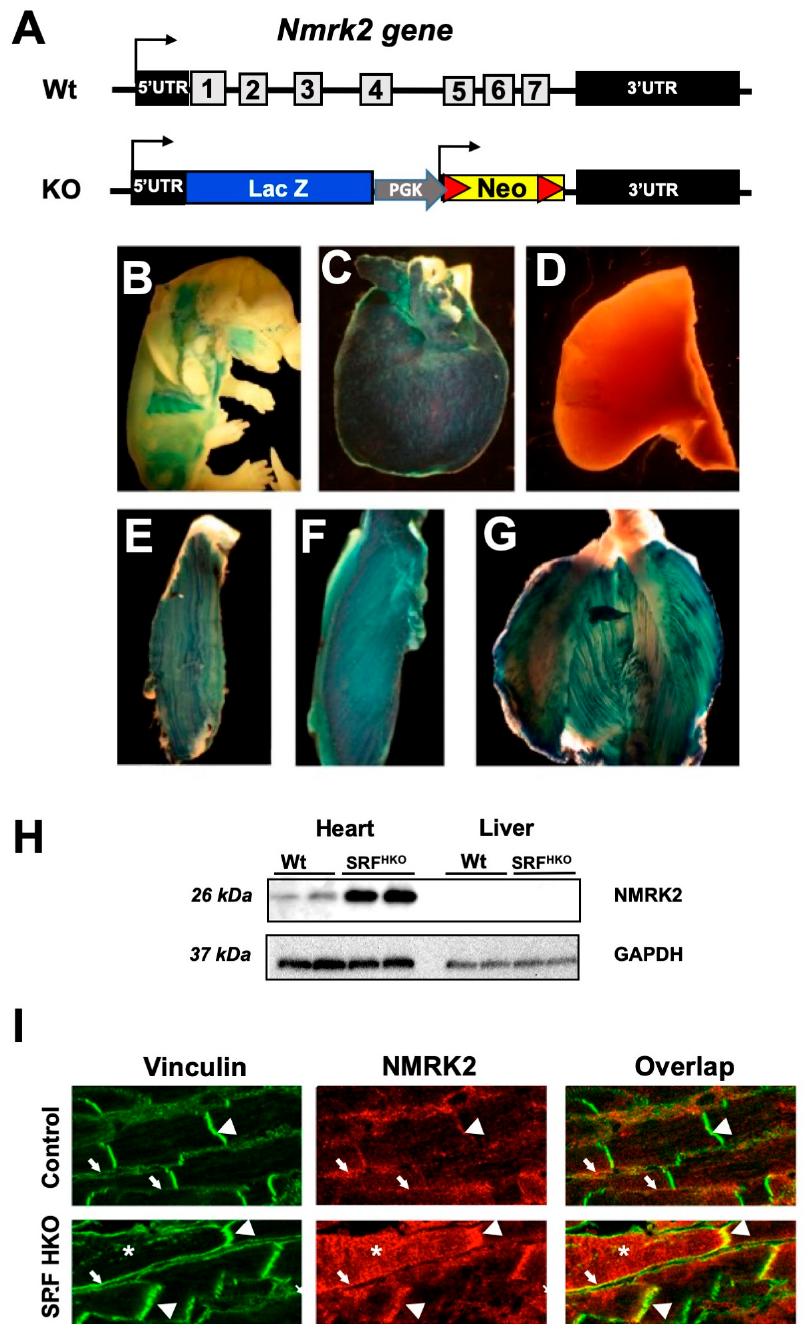
Figure 2. Nmrk2 gene knock-out design and expression pattern. ( A ) Definitive null allele was obtained by replacement of all exons and introns of the Nmrk2 gene by an expression cassette including the lacZ reporter gene and a floxed neomycin resistance gene. ( B – G ) The lacZ gene, which is under the control of Nmrk2 regulatory sequences β -galactosidase staining at embryonic day 14.5 ( B ), in the adult heart ( C ) , the liver (negative) ( D ) and the skeletal muscles; plantaris ( E ), soleus ( F ) and gastrocnemius ( G ) (representative picture of n = 3 mice/group). ( H ) Western blot for NMRK2 protein in indicated tissues from control and SRF-HKO mice. ( I ) Confocal microscopy of cardiac sections stained with anti-h1-Vinculin antibody (green) and anti-NMRK2 antibody (red) in control mice and dilated heart from SRF-HKO mice (representative picture of n = 3 mice/group). Bottom left white Bar = 10 µ m, arrowheads: intercalated disks (stretched in SRF-HKO) , arrows: lateral sarcolemma, asterisks: cytosol filled with